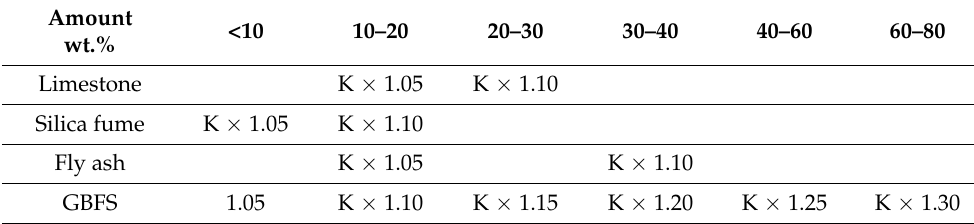
Table 8. Suggested correction factors dependent on the type of